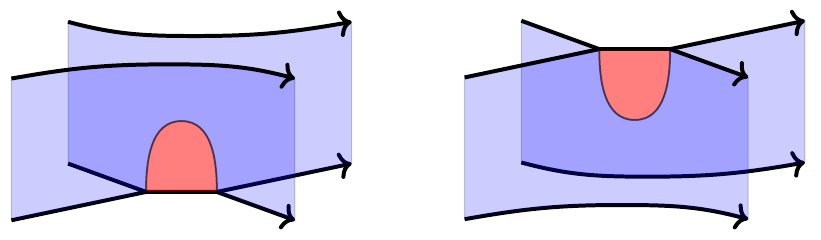
Figure 13 . Simple prefoams for a crossing